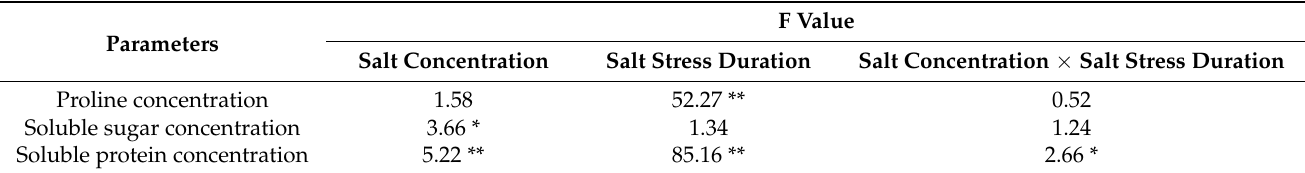
Table 4. Two-factor variance analysis of osmoregulation substances with the factors of salt treatment. *, **: significant at the 0.05 and 0.01 probability levels,